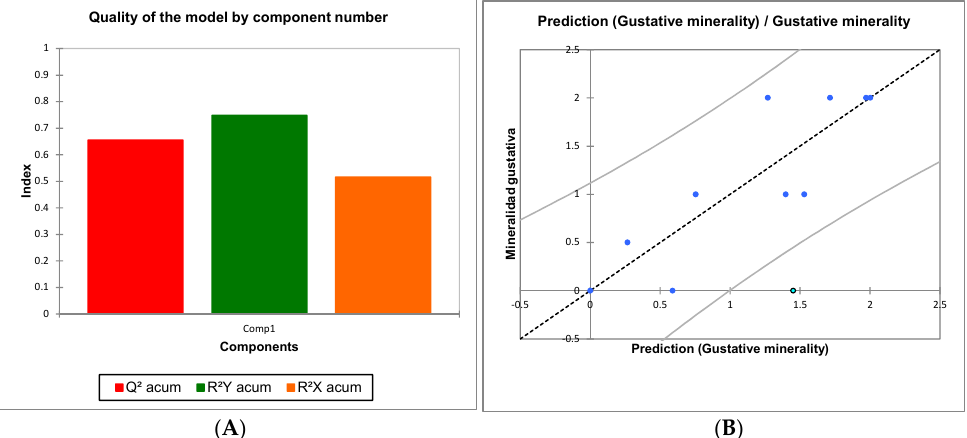
Figure 5. ( A ): Quality of fit of PLS model. ( B ): Distribution of samples of the predictive model for the gustatory “minerality” descriptor based on the chemical profile constructed from the eleven white wines of the study.